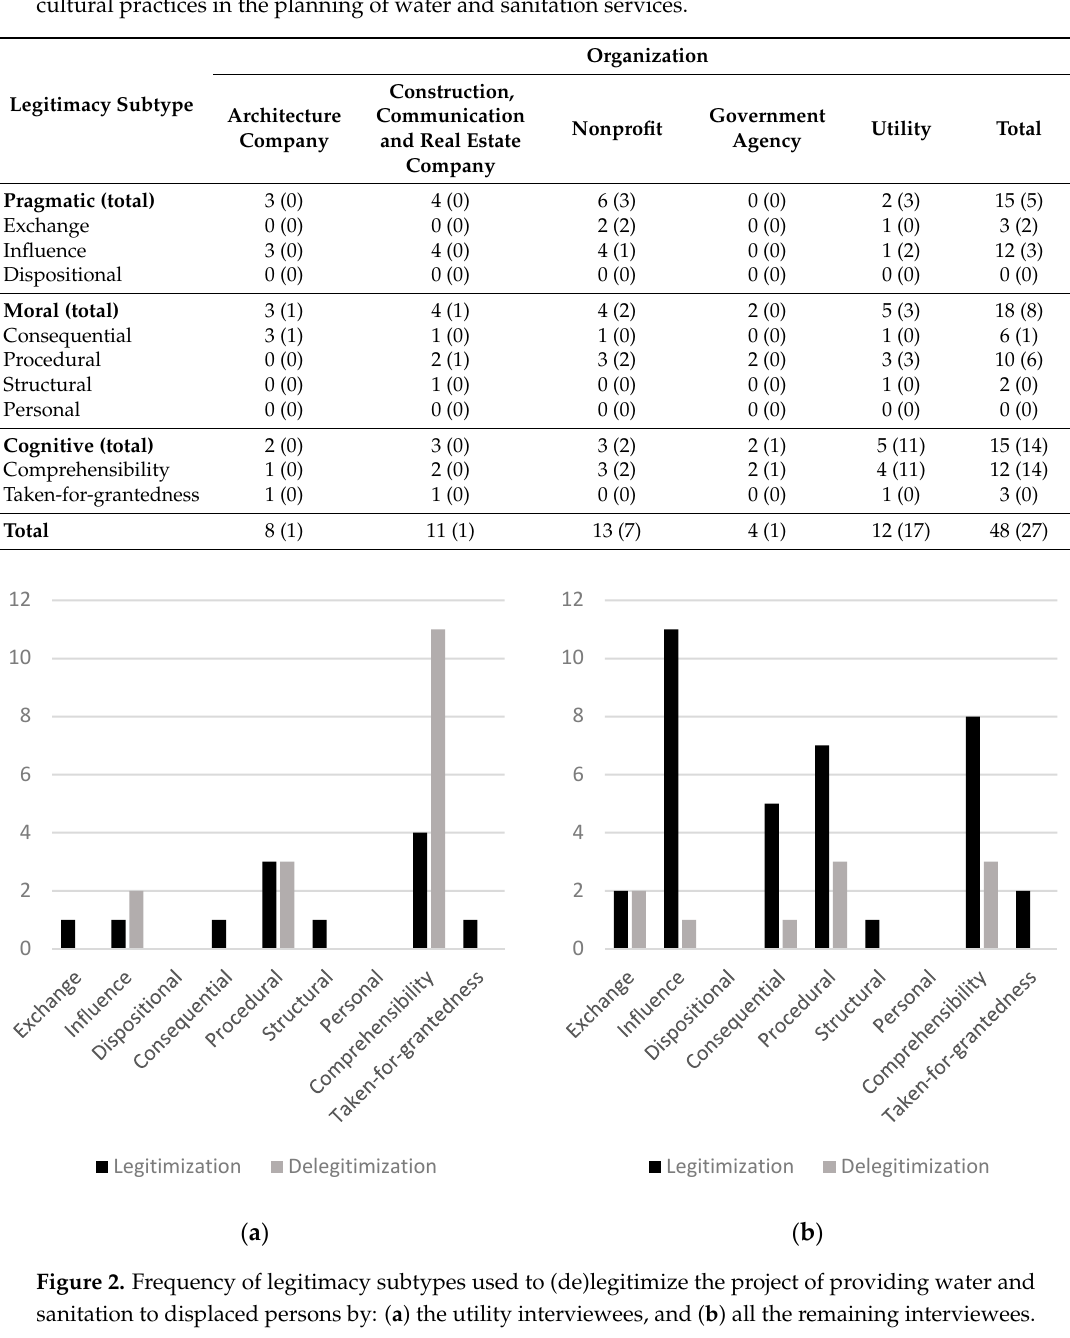
Table 3. Organization and the frequency of legitimacy subtypes used to (de)legitimize the inclusion of cultural practices in the planning of water and sanitation services.